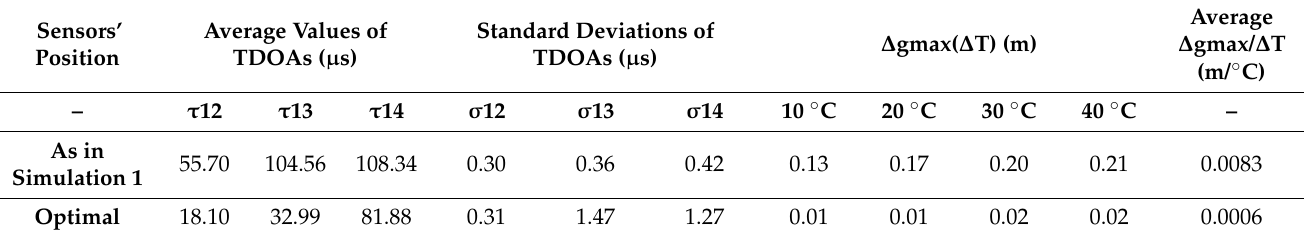
Table 4. Experimental verification of the results of Simulation 2. Significant improvement in the non-iterative algorithm’s sensitivity to the transformer oil temperature achieved by placing the sensors in the optimal position.